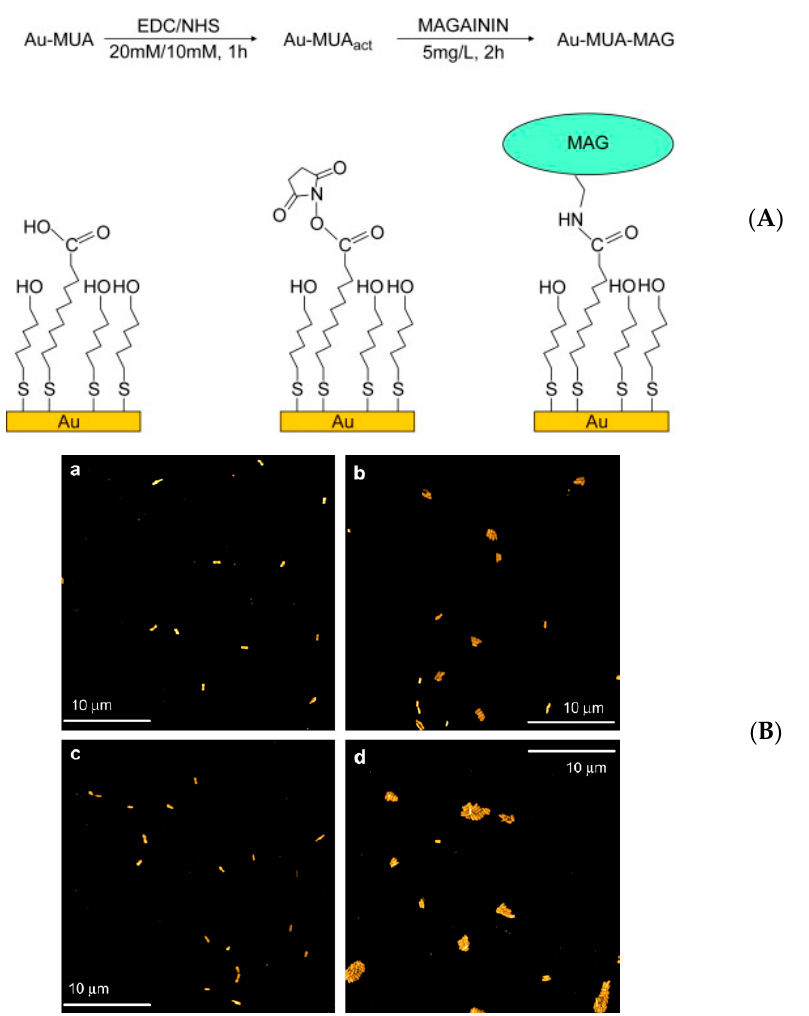
Figure 5. ( A ) Scheme of magainin I immobilization. Step 1: formation of SAM of MUA on gold, Au-MUA; step 2: esterification of the COOH function of MUA by NHS/EDC, Au–MUA act ; step 3: covalent binding of magainin I, Au–MUA–MAG ( B ) AFM images of gold samples Au–MUA ( a , c ) and Au–MUA–MAG ( b , d ) obtained after 30 min and 3 h, respectively, of contact with a Listeria ivanovii bacterial suspension at 1.5 × 10 6 cfu/mL at 37 ◦ C; imaging conditions: 50 µ m × 50 µ m, 512 lines, 2 Hz, tapping mode. Reproduced from [71]. Copyright © 2009 Elsevier Ltd. All rights